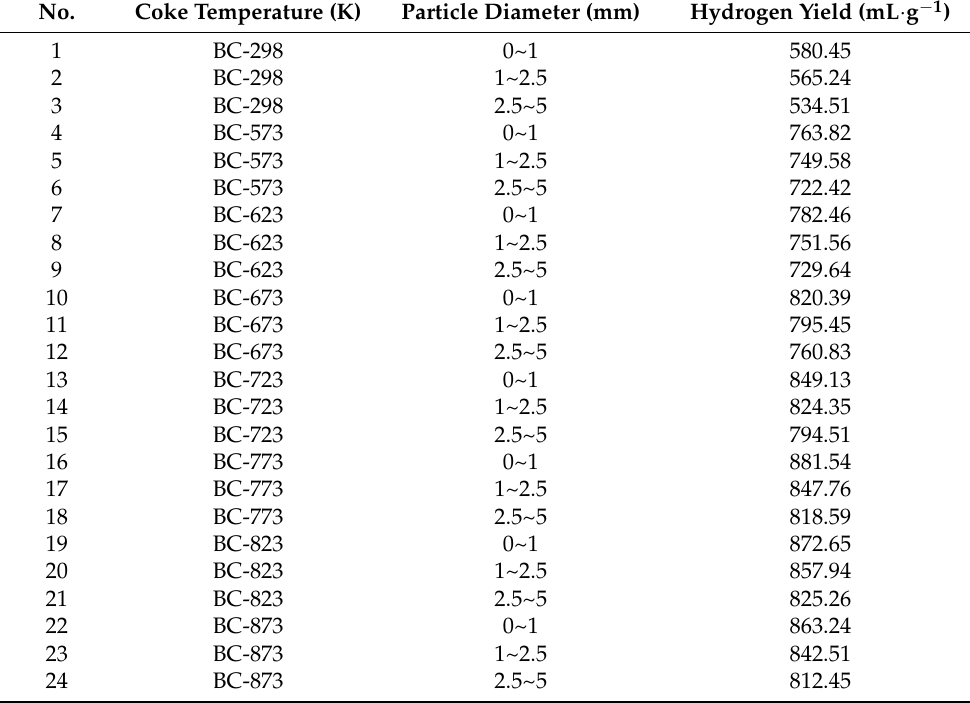
Table 5. Hydrogen yield from semi-coke